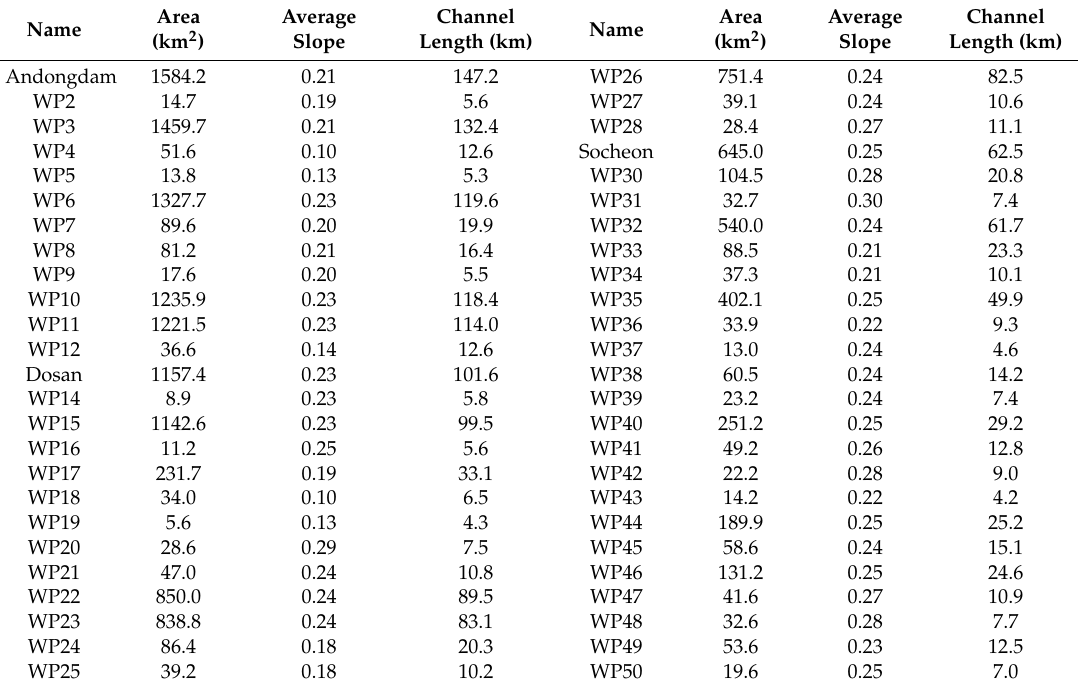
Table A3. Size of area, average slope, and channel length of the catchment for the 50